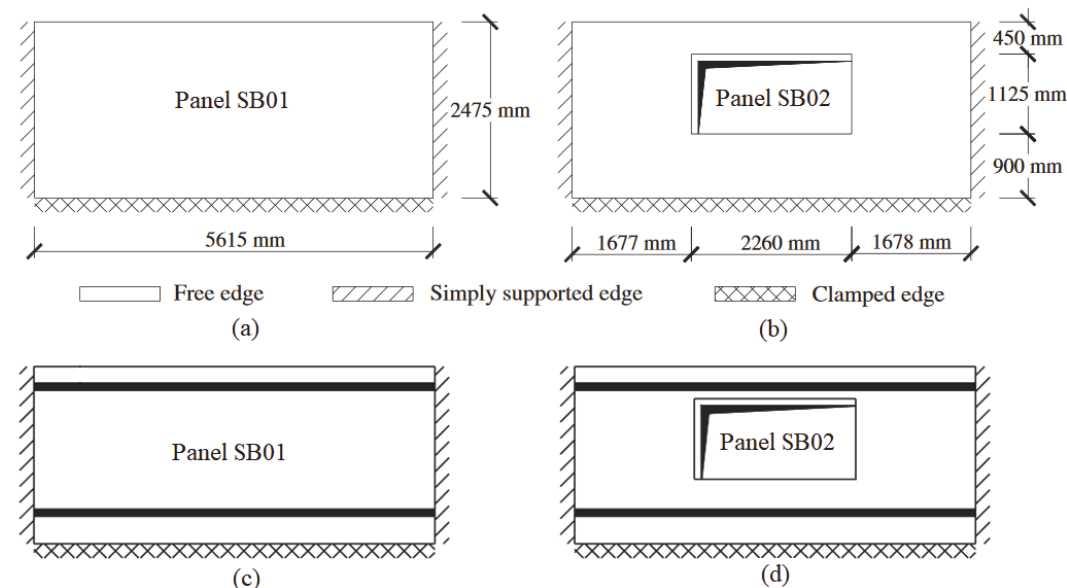
Figure 7: (a-b) Geometry of wall specimens SB01 and SB02; (c-d) FRP reinforcement configuration for specimens SB01 and